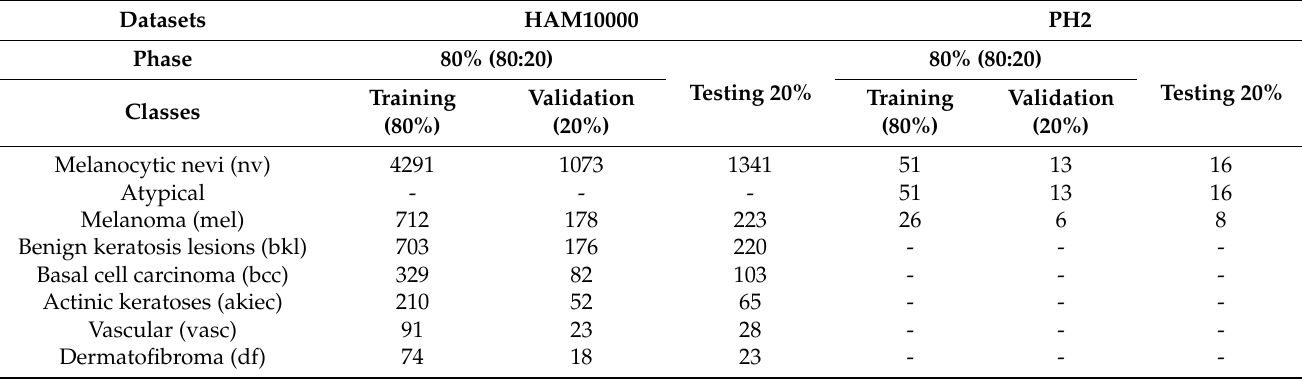
Table 1. Splitting the HAM10000 and PH2 data sets of skin